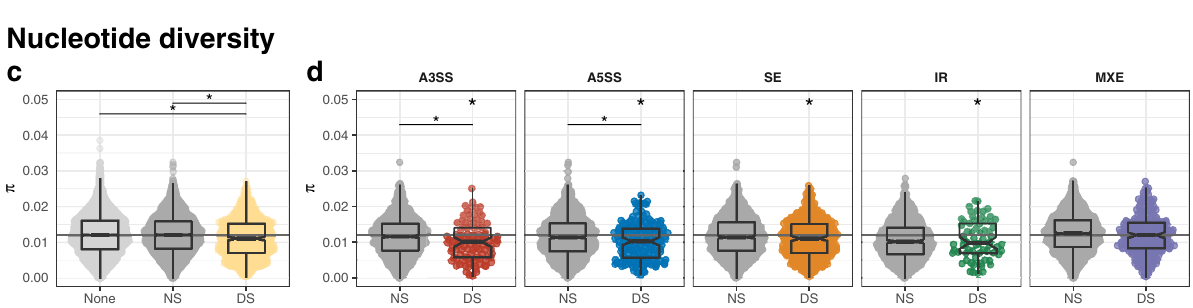
Fig. 4 Erosion of genetic variation differs among alternative splice event types. a We analysed fi ve major splice event types: alternative 3 ′ (A3SS) and 5 ′ splice sites (A5SS), skipped exons (SE), intron retention (IR), and mutually exclusive exons (MXE). In the abdomen, b small subsets of detected splice events were signi fi cantly differentially spliced (coloured bars) between seasonal morphs. The panel to the right zooms out to show all detected events (dark grey bars outlined in black). c Nucleotide diversity ( π ) among genes with no splicing events (None, light grey), nonsigni fi cant splicing (NS, dark grey) and differential splicing by season (DS, yellow) indicate that seasonally spliced genes have decreased polymorphism. The horizontal grey line indicates the median π for genes with no splicing ( “ None ” ). d For genes containing one event type, π was lower in DS genes compared to both NS genes across all event types. The grey line extends from c . DS genes for all event types were also different from genes with no splice events c , d. Point clouds represent π values for each gene set. Values are summarized with boxplots: the center line represents the median, the box encloses the 25 th – 75 th quartiles and is notched ffiffiffi p (median ± 1.58 * interquartile/ n ), and whiskers extend to 1.5x the interquartile range. An asterisk (*) centred over a horizontal line between groups indicates a meaningful statistical difference between these groups whereas an asterisk centred over the DS points indicates a statistical difference from the grey line (Bayesian linear models, Supplementary Fig. 11A, 13A). See supplementary Fig. 10, 11, 13 and Supplementary Table 8, 9 for fi gures and analyses based on thorax samples. Source data are provided as a Source Data fi